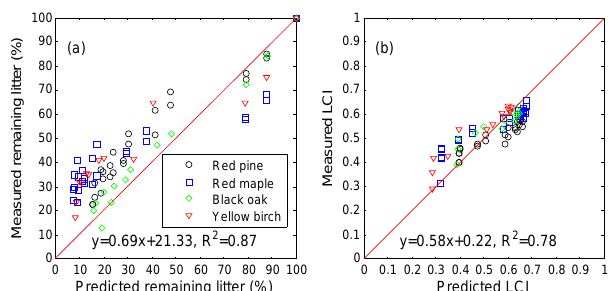
Fig. 15. Evaluation of model (S3B3-ECA) prediction using Magill et al. (1998) litterbag experiment data: (a) remaining litter biomass and (b) litter lignocellulose index (LCI). The original and corrected lignin data are in Fig. S1.